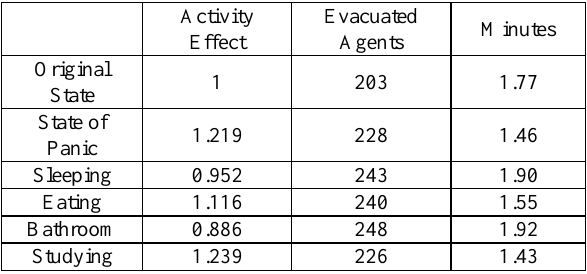
Table 1. Summary of values for each parameter simulation